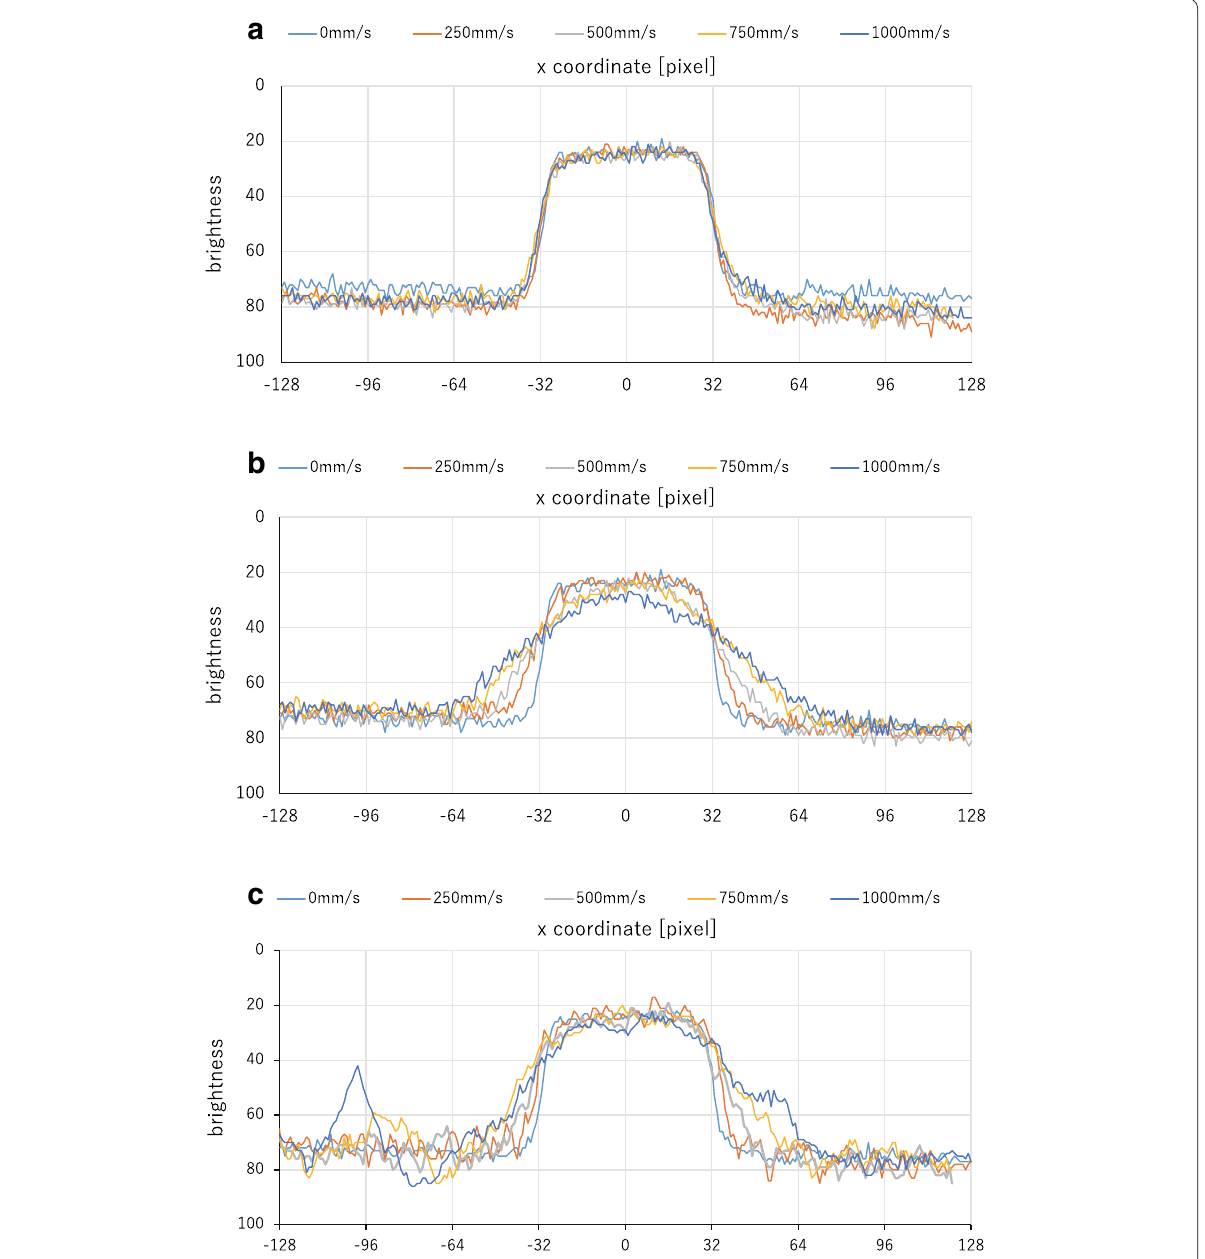
Fig. 12 Intersected brightness profiles when a circle-dot moved in the horizontal direction. a With tracking (IT). b Without tracking (NT). c Motion deblurring